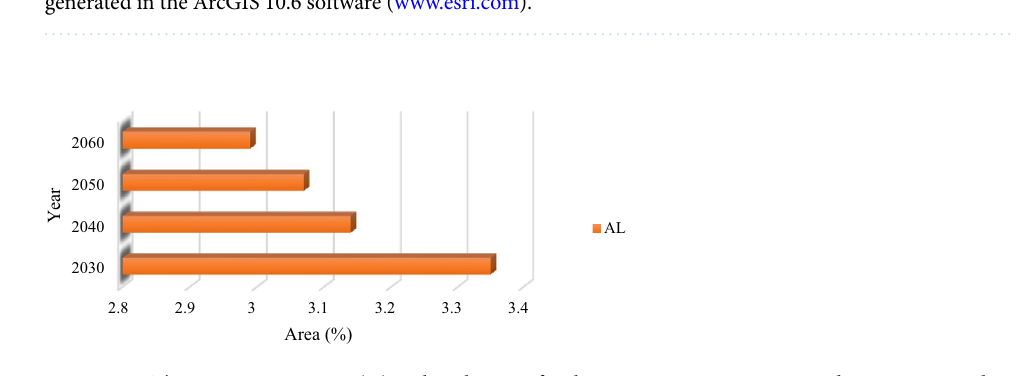
Figure 11. The AL areas variation (%) within the LUB for the years 2030, 2040, 2050, and 2060, generated in Microsoft Excel 2022 software (www. micro soft.